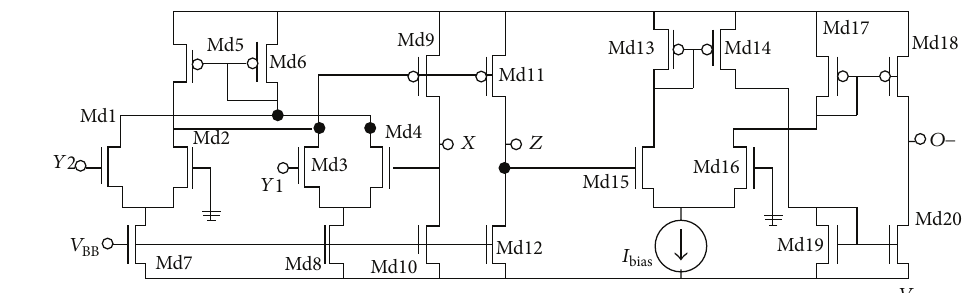
Figure 2: CMOS implementation of DVCCTA [16].